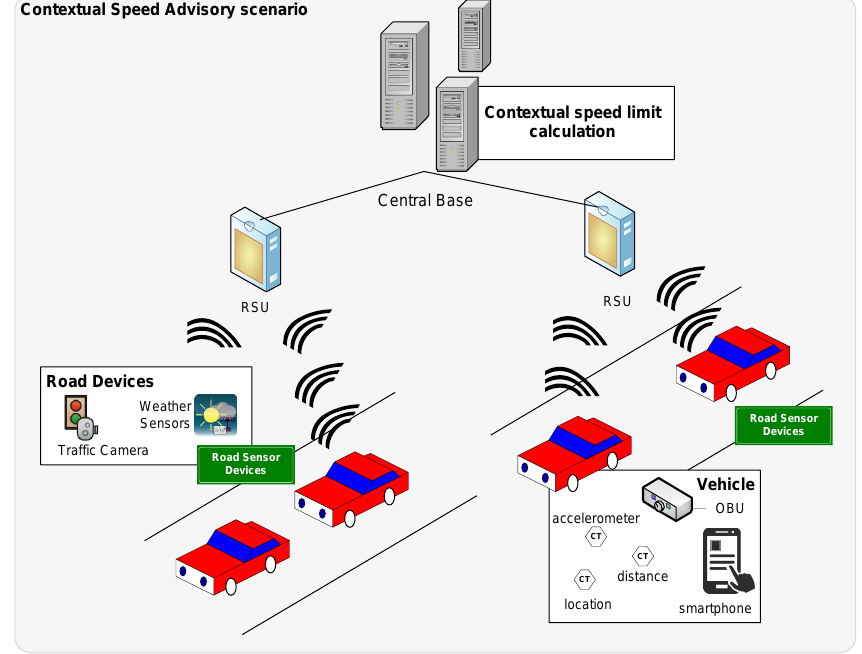
Figure 3. A context speed advisory (CSA)